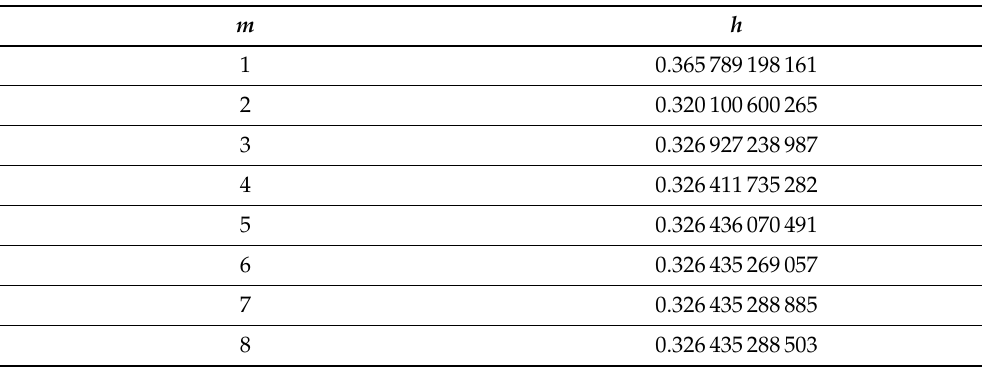
Table 1. A family of singular points, f =